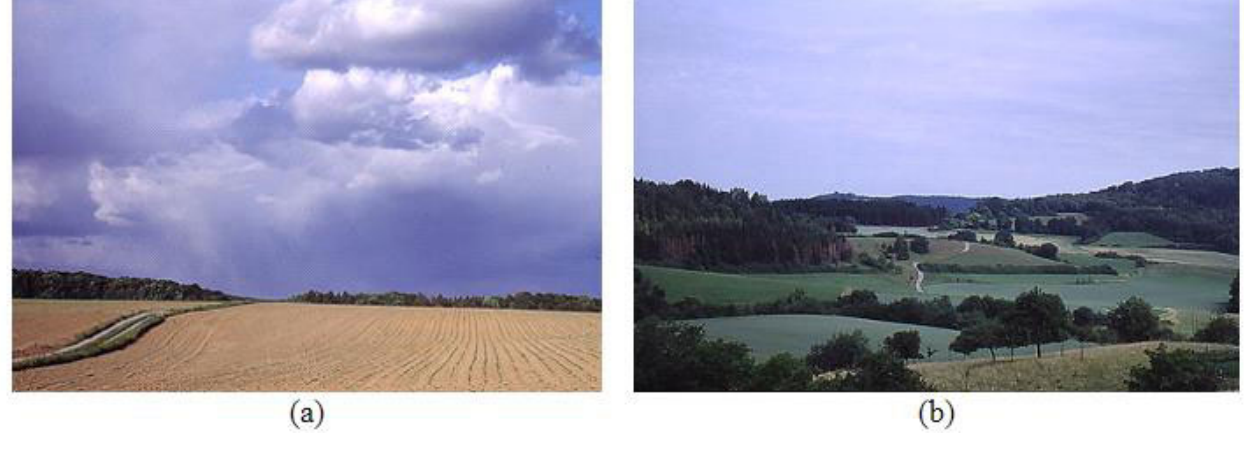
Fig. 3. Examples of farming in Hohenlohe (a) on the Hohenlohe plains, (b) in the valleys Source: http://